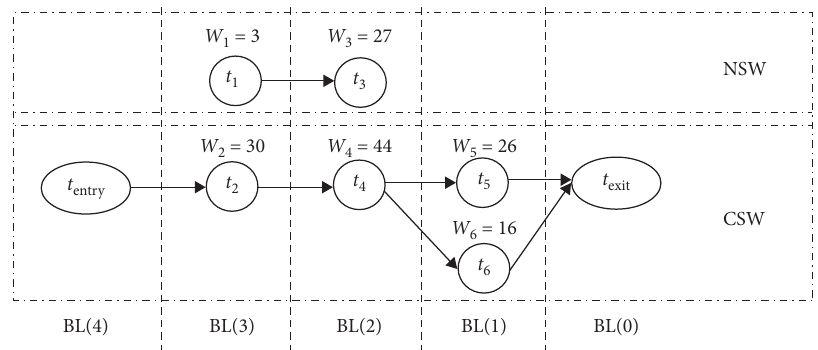
Figure 4: A partition of sample